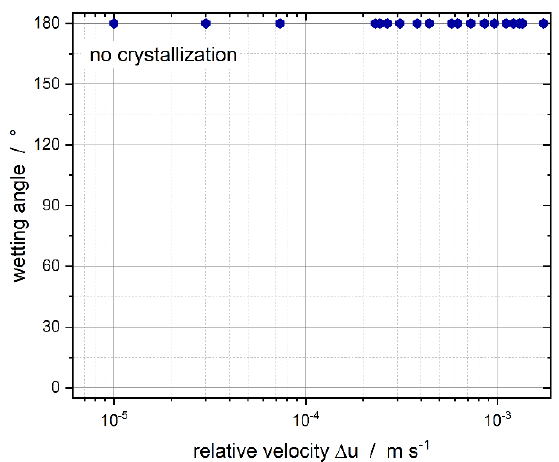
Figure 11. Wetting angle as a function of the relative droplet velocity for the equilibrium surfactant distribution between the continuous and dispersed phase, determined from long-term spectroscopy measurements (compare Figure 9).